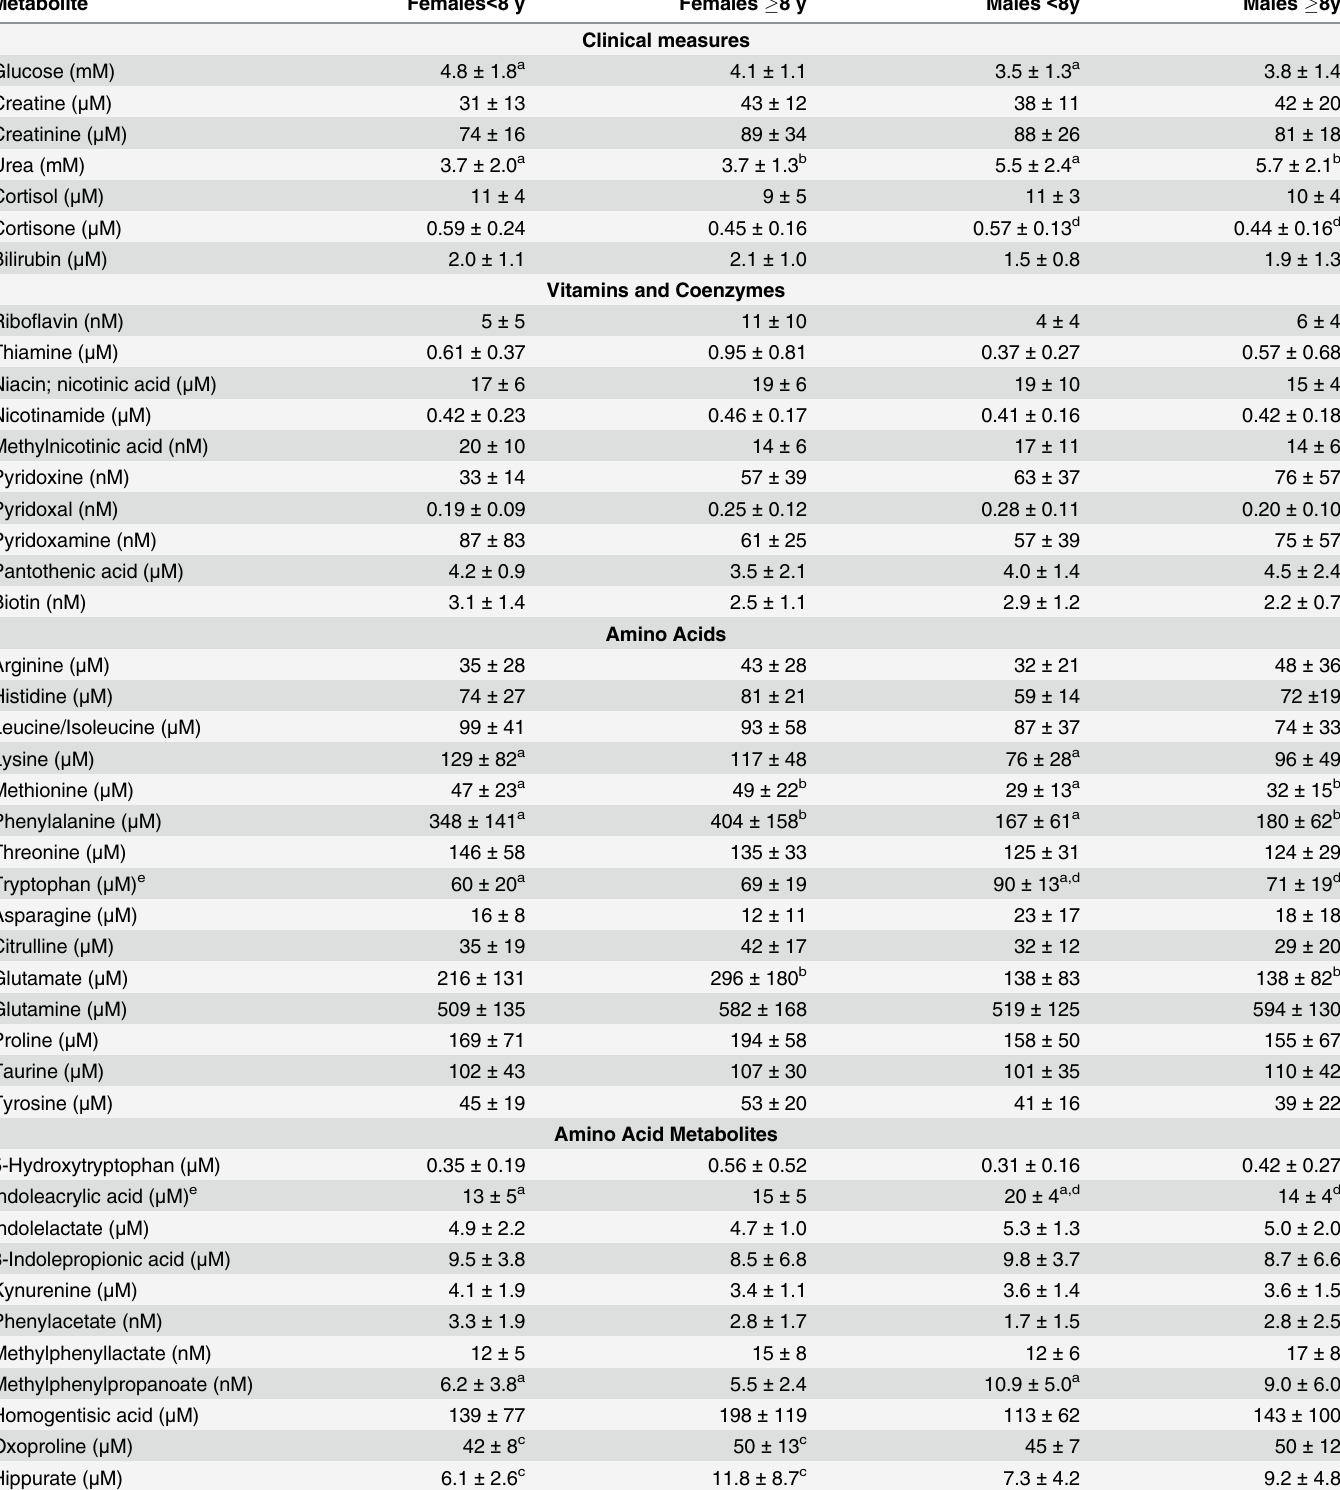
Table 2. Marmoset plasma metabolite concentrations according to age group and